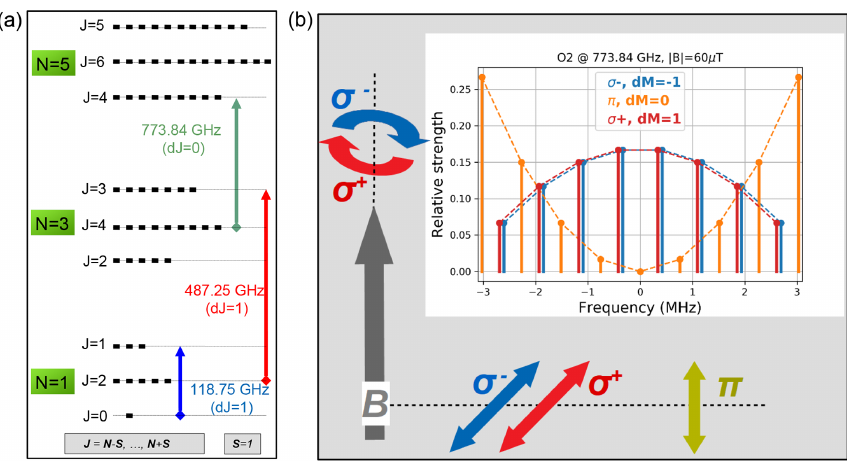
Figure 3. (a) Energy levels of the O 2 transitions measured with MLS at 119GHz (Schwartz et al., 2006), SMR at 487GHz (Larsson et al., 2014) and SMILES-2. The degenerated energy levels ( M = − J...J ) are indicated with black horizontal strokes. (b) Strength and polarization of the Zeeman components of the line chosen for SMILES-2. The components’ frequency is computed for a magnetic field of 60µT (0.6Gs). The representation of the polarization states is adapted from Fig. 3.1 in Landi Degl’Innocenti and Landolfi (2004). The dashed lines represent perpendicular and parallel LOSs with respect to B (grey thick